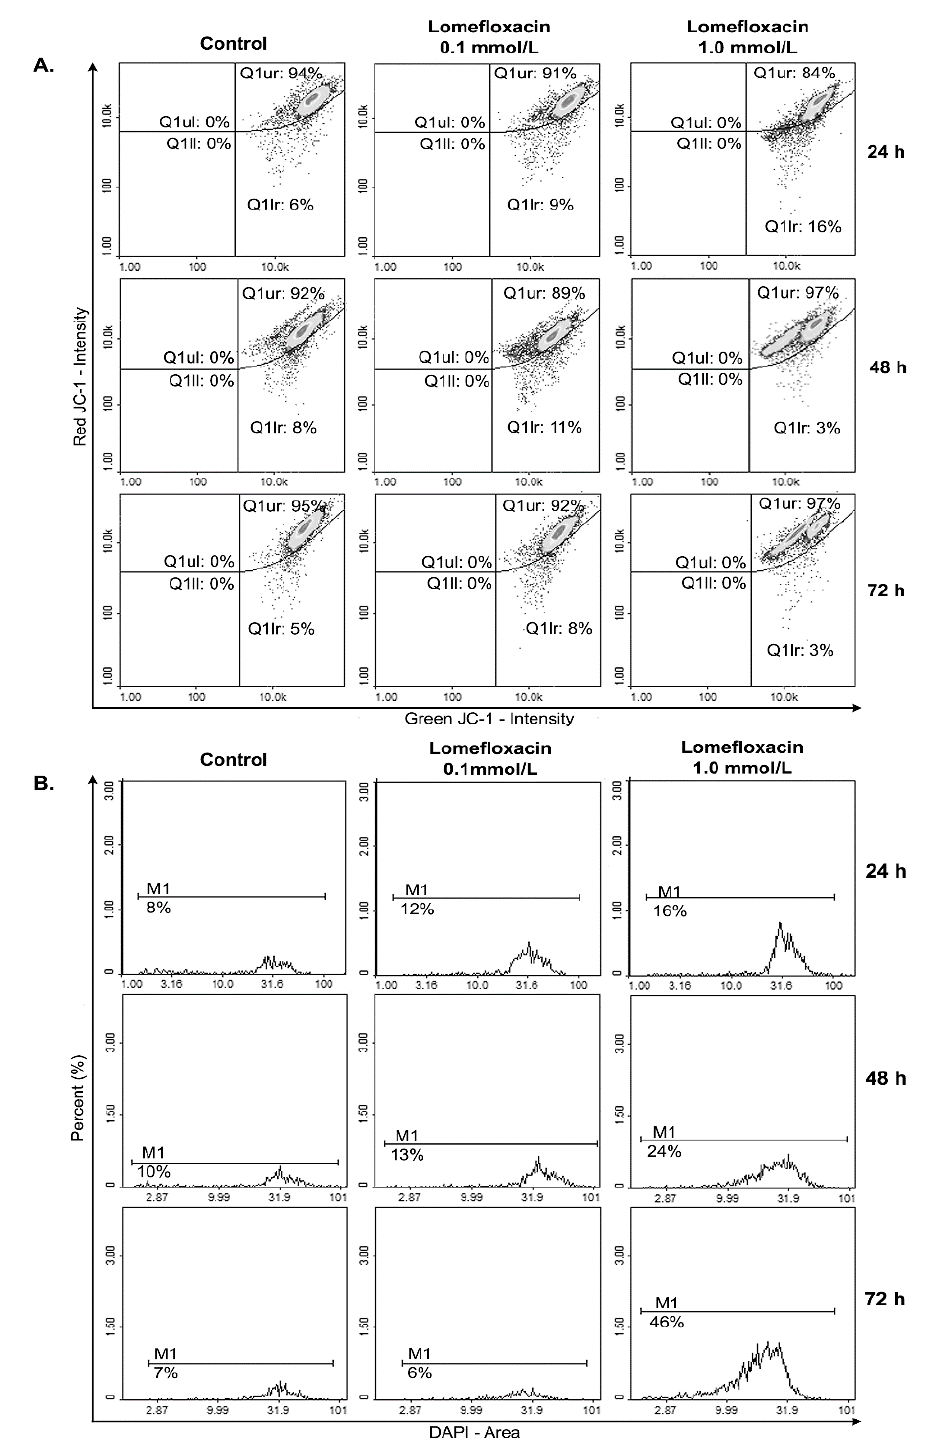
Figure 7. Lomefloxacin induces apoptosis in the COLO829 melanoma cell line. The cells treated with lomefloxacin in concentrations of 0.1 and 1.0 mmol/L for 24, 48, and 72 h were stained with ( A ) JC-1 and ( B ) DAPI dyes and analyzed by a fluorescence image cytometer. The presented histograms are representative of three independent experiments with similar results.